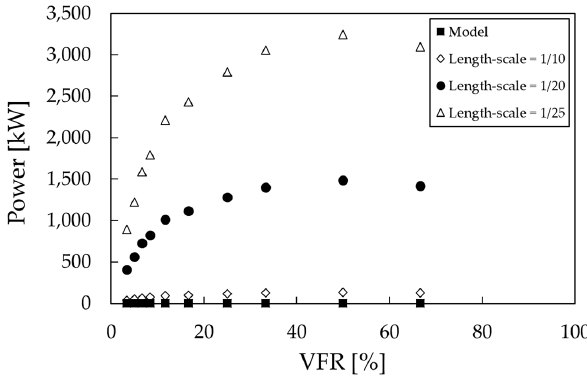
Figure 11. Hydraulic prototype power for different length-scales and VFRs.